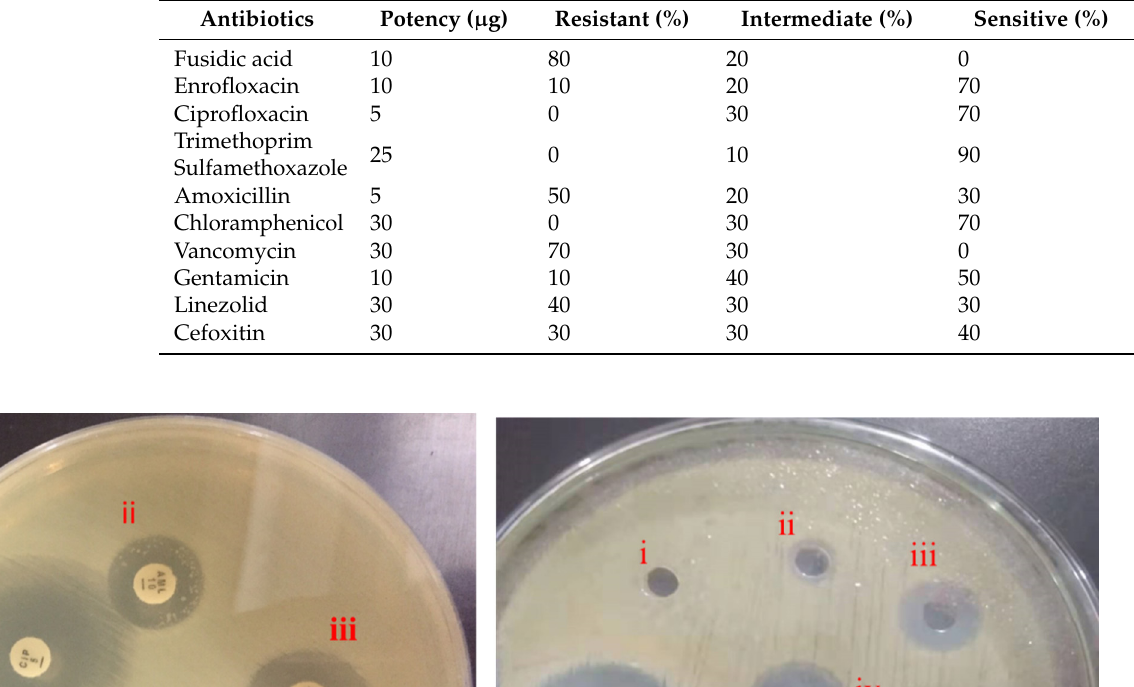
Table 3. Antibiogram of E. coli isolates.